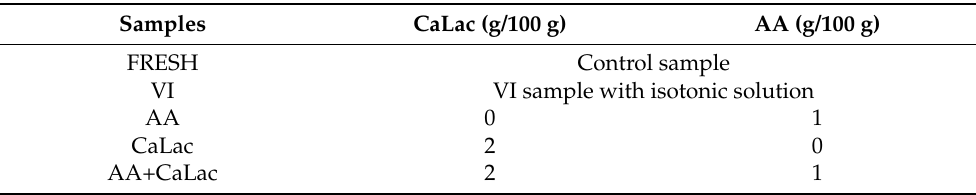
Table 1. Abbreviations for apple samples subjected to the vacuum-impregnation (VI) treatments with different